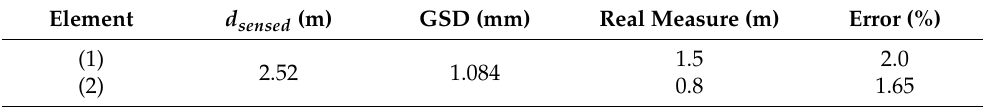
Table 6. Real measurement and error corresponding to the two reference measures taken of the tunnel wall. The distance from which the image was captured, as well as the computed GSD, for the image shown in Figure 13a is also